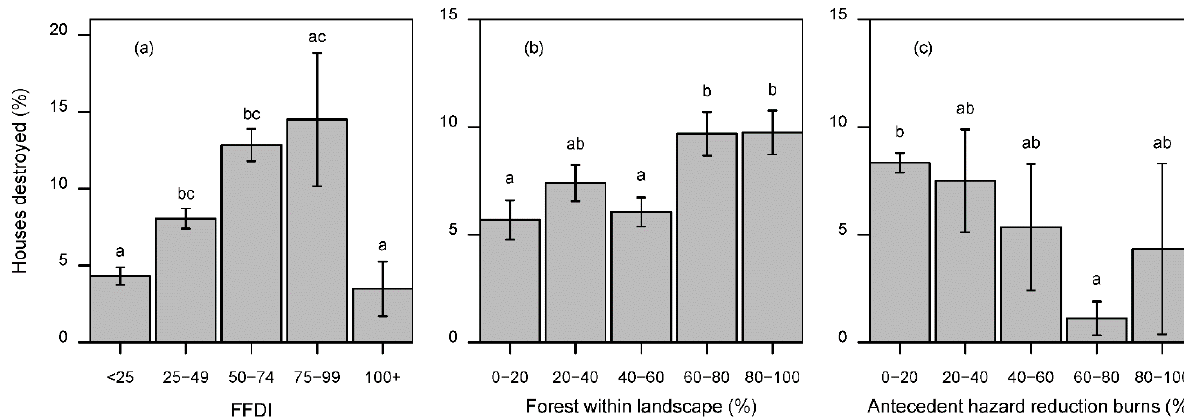
Figure 3. We related the percentage of houses destroyed in 1 km 2 blocks of fire-affected areas ( n = 1100) to a range of predictors, including: ( a ) fire weather (Forest Fire Danger Index, FFDI); ( b ) the percentage of the surrounding landscape (within 5 km 2 ) comprised of forest; and ( c ) the percentage of the surrounding neighbourhood (1 km 2 ) treated with hazard reduction burns in the five years preceding the 2019–20 fires. The percentage of houses destroyed represent the mean percentage of houses destroyed ( ± 1 SE) within 1 km 2 hexagons. Different letters above bars indicate statistically significant differences between categories ( p <